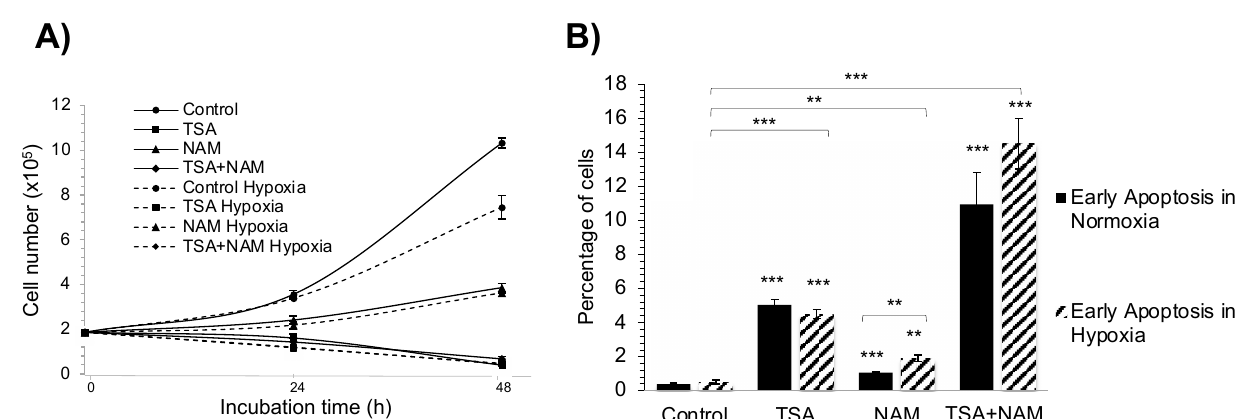
Figure 1. ( A ) Effect of trichostatin-A (TSA) and nicotinamide (NAM) treatments on A549 cell proliferation. A549 cells treated with 1 μ M TSA, 20 mM NAM, or both 1 μ M TSA and 20 mM NAM for 24 h and 48 h of incubation under normoxia or hypoxia. Dots represent means ± standard deviations of three independent experiments. ( B ) Apoptosis analysis of KDACI-treated A549 cells under normoxia and hypoxia. Apoptosis was measured after 24 h of incubation. Cells in the stage of early apoptosis are represented as the percentage with respect to total cells. A549 cells were treated with 1 μ M TSA, 20 mM NAM or both 1 μ M TSA and 20 mM NAM for 24 h under normoxia or hypoxia. Bars represent the means ± standard error of the mean of three independent experiments. The asterisks above bars indicate statistically significant differences compared to normoxic control cells. Asterisks above curly brackets indicate statistically significant differences between hypoxic and normoxic treatments and between hypoxic treatments and hypoxic control cells. Statistical signifi- cance was assessed by a two-tailed Student’s t -test. ** p ≤ 0.01; *** p ≤ 0.001.